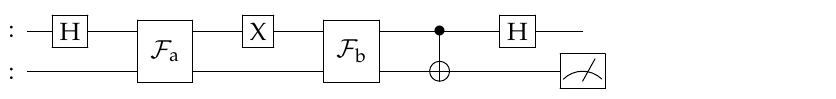
Figure 2. Visualization of the quantum circuit implementing the operator F − for calculating the difference of two functions f a , f b implemented by the operators F a , F b . Note that both functions f a , f b may also depend on some state register | x k (cid:105) if needed. The last Hadamard application uncomputes the qubit |·(cid:105) a